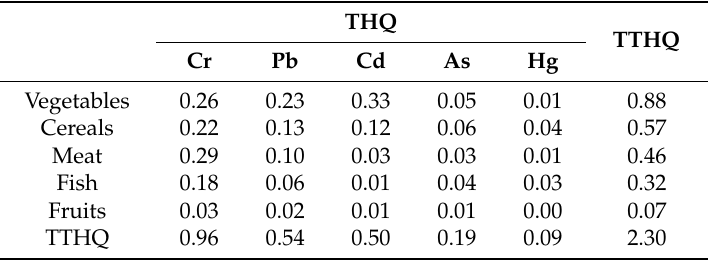
Table 4. Target hazard quotients (THQ) and total target hazard quotients (TTHQ) of the studied metals caused by the consumption of foodstuffs for inhabitants in